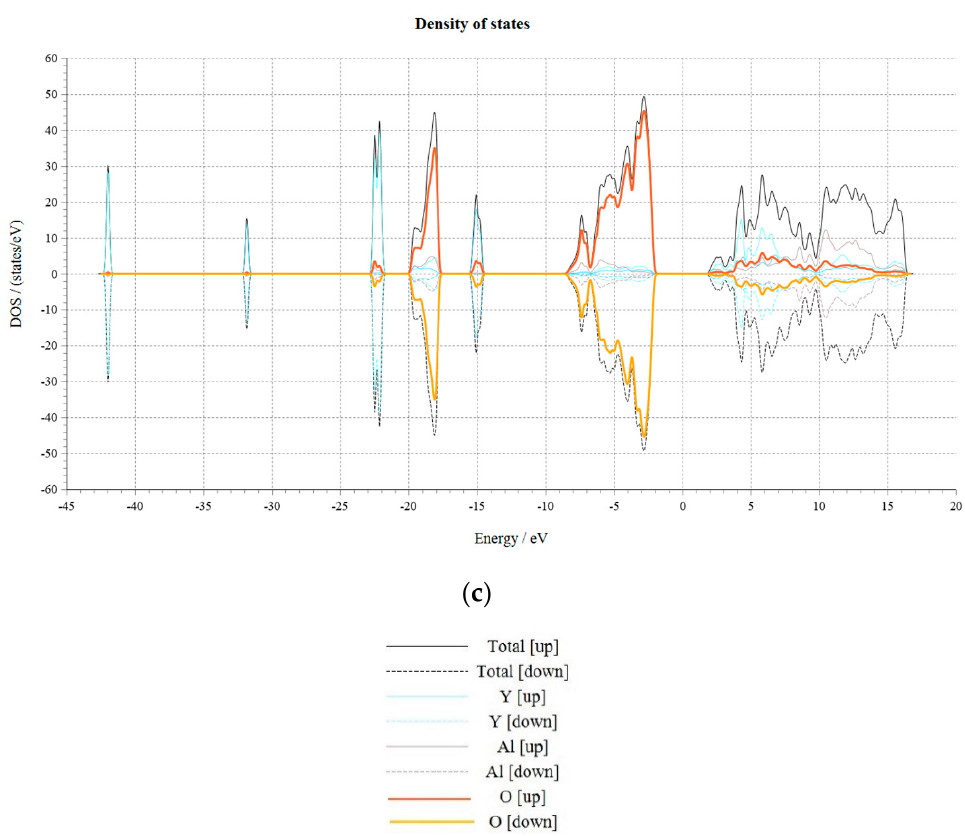
Figure 3. Density of states ( a ) Y 3 Al 5 O 12 , ( b ) Y 3 Al 5 O 12 :La (2 ions), ( c ) Y 3 Al 5 O 12 :La (4 ions).